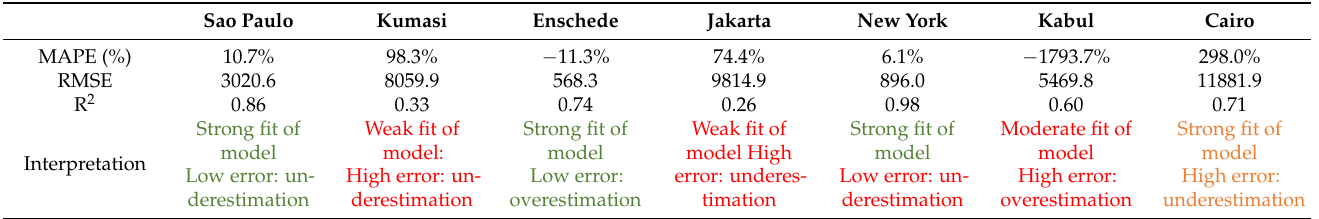
Table 6. Overall error estimation comparison of case studies (Colors represent: red: weak model fit, orange: moderate model fit and green: strong model